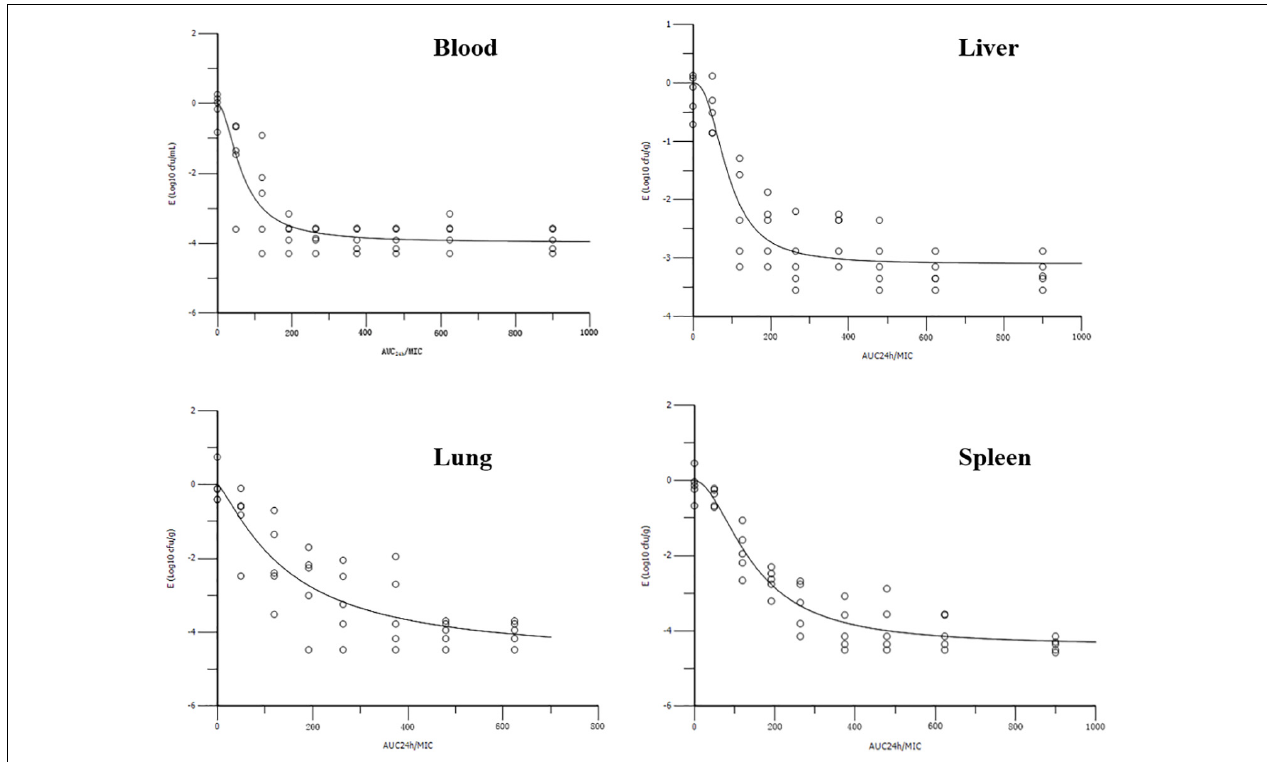
FIGURE 4 | Sigmoid E max relationships between danofloxacin’s antibacterial effect in the blood, liver, spleen, and lung [E, Log 10 colony forming units (cfu)/mL or Log 10 cfu/g] and the in vivo area under the concentration-time curve from 0 to 24 h (AUC 24 h )/minimum inhibitory concentration (MIC) ratio in rabbits.